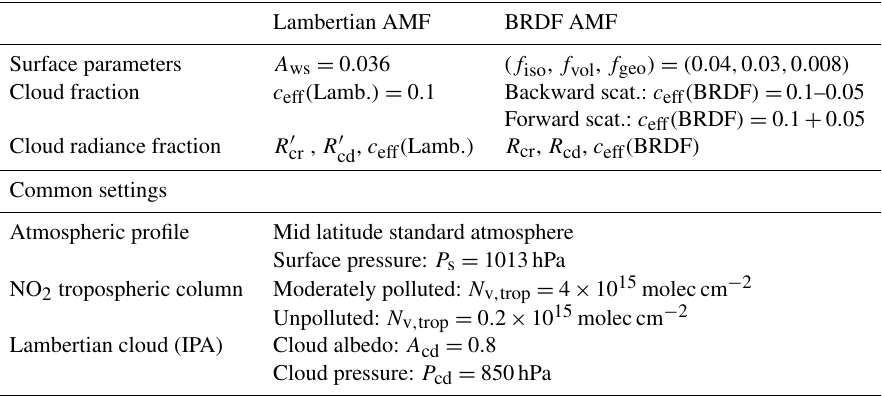
Table 2. Settings for the Lambertian and BRDF tropospheric NO 2 AMF calculations shown in Fig.